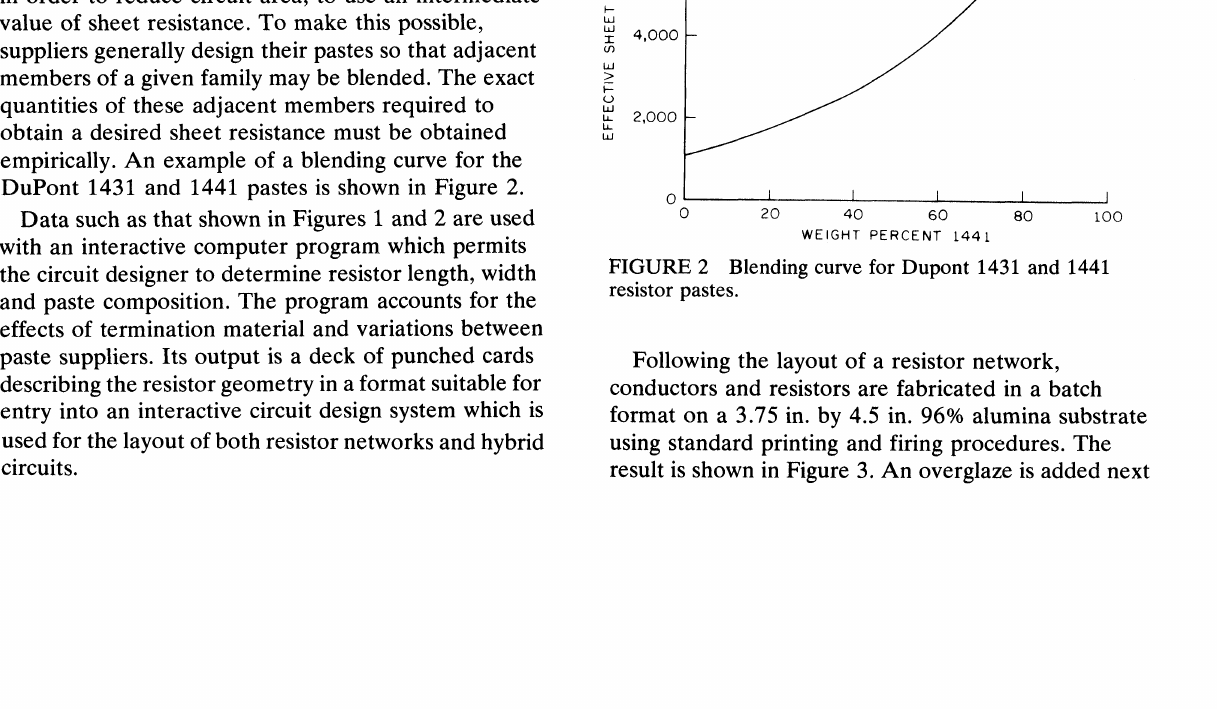
FIGURE 2 Blending curve for Dupont 1431 and 1441 resistor